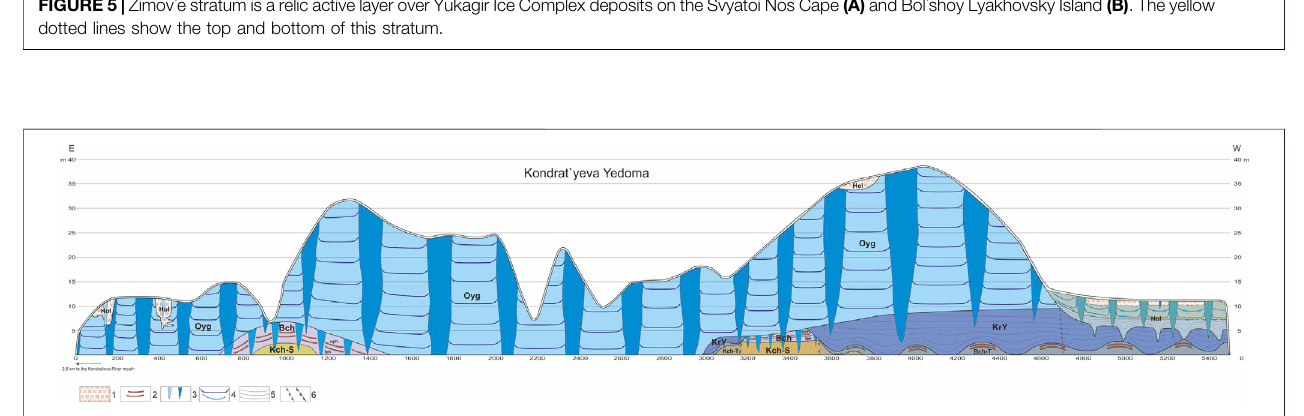
FIGURE 6 | Cryolithostratigraphic structure of the Kondrat`yeva yedoma section on the Oyogos Yar at a site 2.5 – 8 km west of the Kondrat`yeva River mouth. Legend: 1 — peat, 2 — lenses of polygonal autochthonous peats and peaty aleurites, 3 — ice wedges of different generations, 4 — ice belt cryogenic structures in syncryogenic deposits, 5 — strati fi cation of sediments in deposits, and 6 — boundaries between taberal and non-thawed deposits. The unit`s symbols explained in Table 1 (in addition: Bch-T stands for Bychchagy Ice Complex taberal deposits).